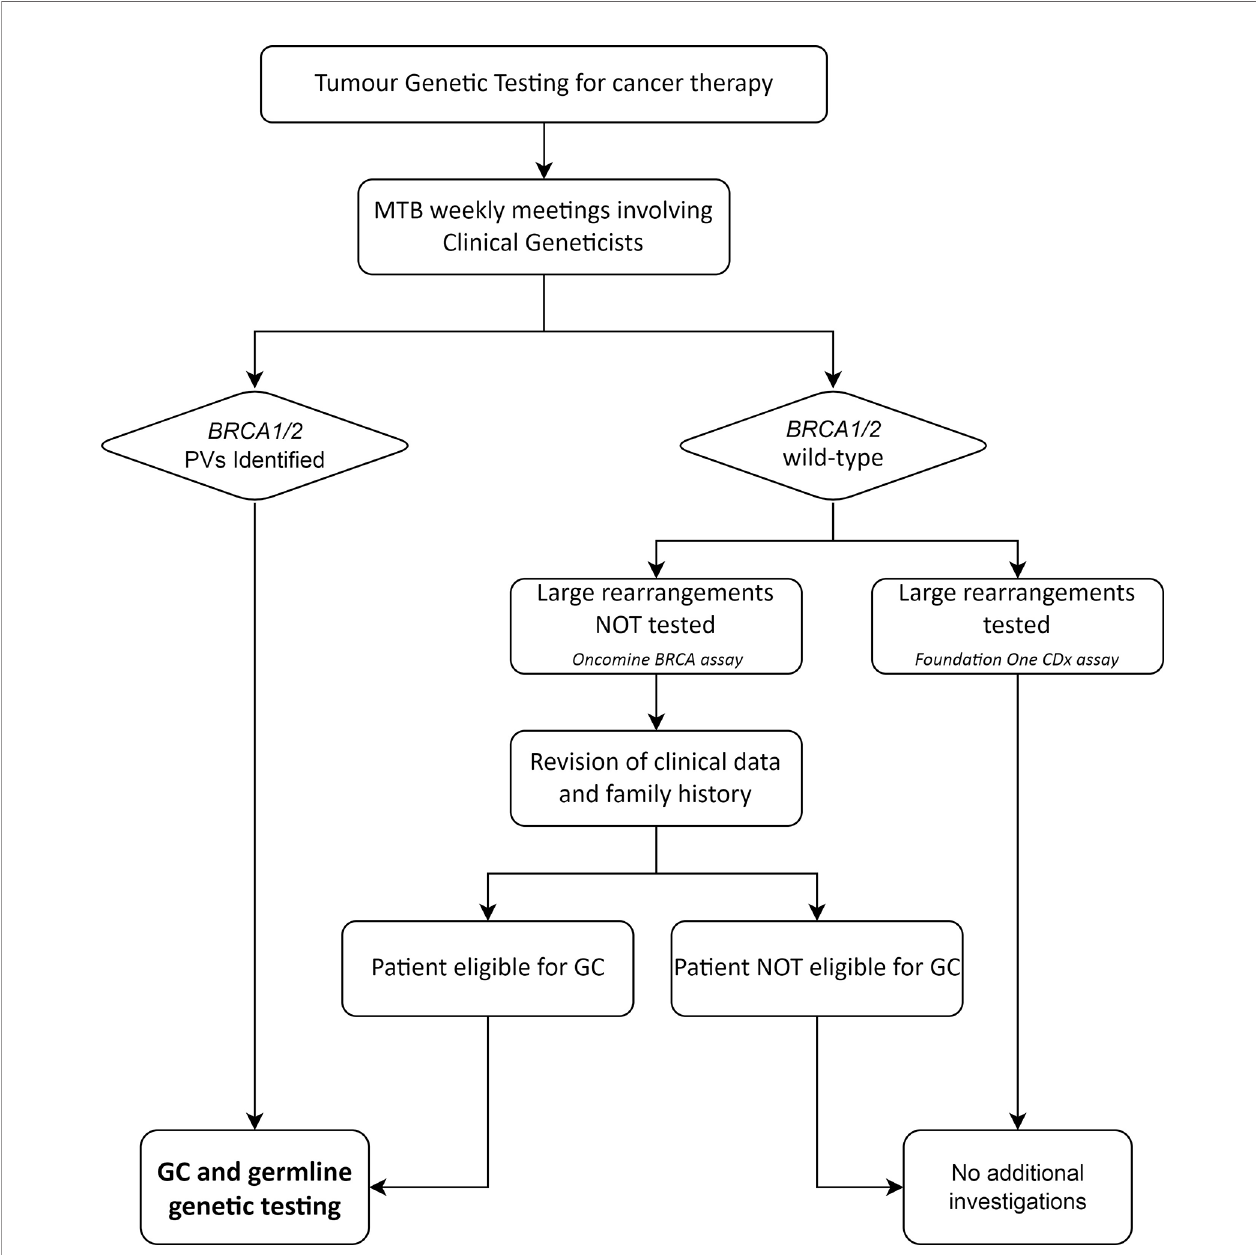
FIGURE 1 | Work fl ow of the management of BRCA tumour testing results with potential germline implications. MTB, Molecular Tumour Board; GC, genetic counselling; PVs, pathogenic/likely pathogenic